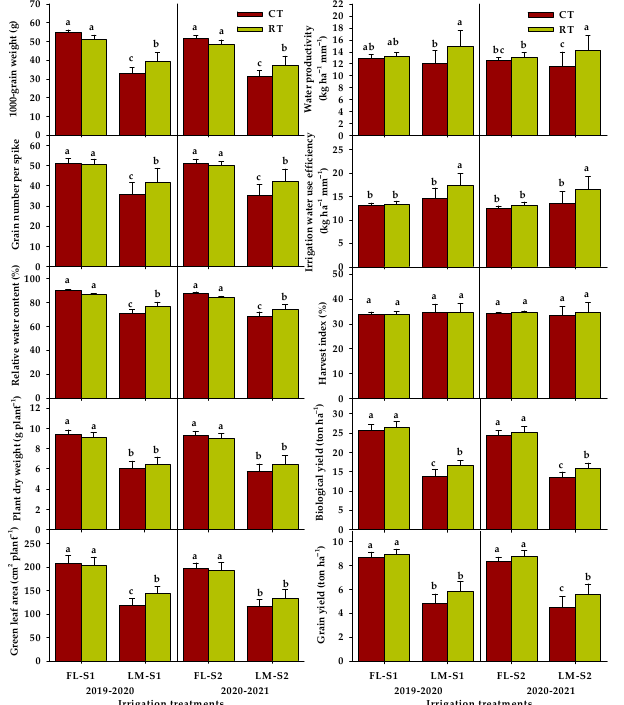
Figure 4. Response of different traits of wheat to the interaction between tillage practices and irrigation regimes in 2019 − 2020 (S1) and 2020 − 2021 (S2) growing seasons. Abbreviations in the figure indicate conventional tillage (CT), reduced tillage (RT), full irrigation regime (FL, 1.00 ET) and limited irrigation regime (LM, 0.50 ET). The different letters indicate statistical significance at the 0.05 level.